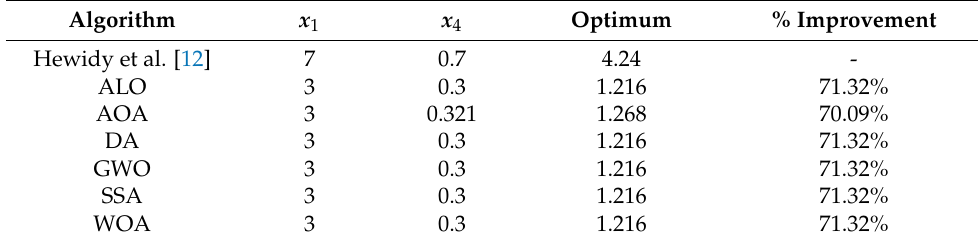
Table 4. Comparison of current results with solutions from literature for WR optimization.